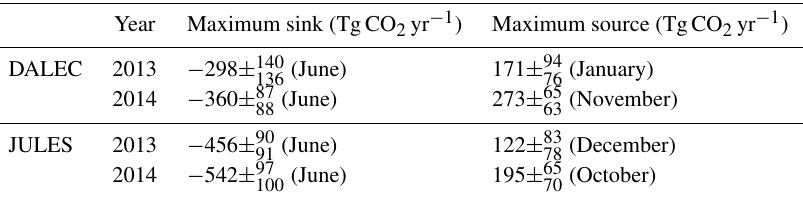
Figure 4. Prior average flux maps for summer 2014 (June–August 2014). (a) TER from DALEC; (b) TER from JULES; (c) the difference between DALEC and JULES TER; (d) GPP from DALEC; (e) GPP from JULES; (f) the difference between DALEC and JULES GPP; (g) NEE from DALEC; (h) NEE from JULES; (i) the difference between DALEC and JULES NEE. Table 4. Posterior UK estimates for the maximum net biospheric source and sink (values also shown in Fig. 5). The month in brackets indicates the month in which the maximum source or sink